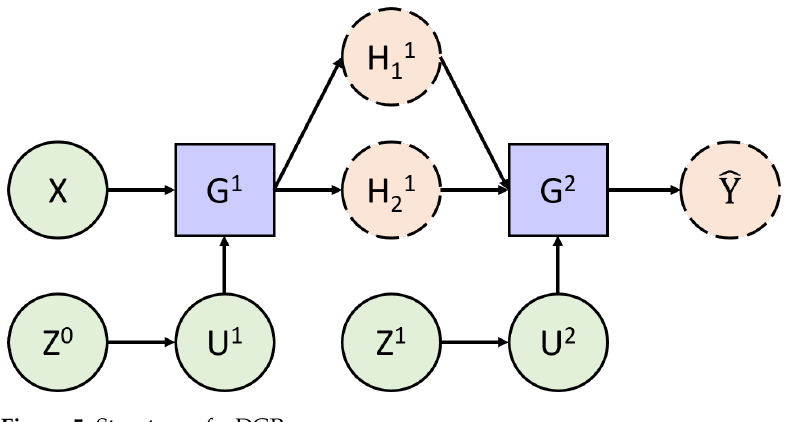
blue rectangles symbolise the conditioning process. In addition, each layer is conditionally independent to the others.